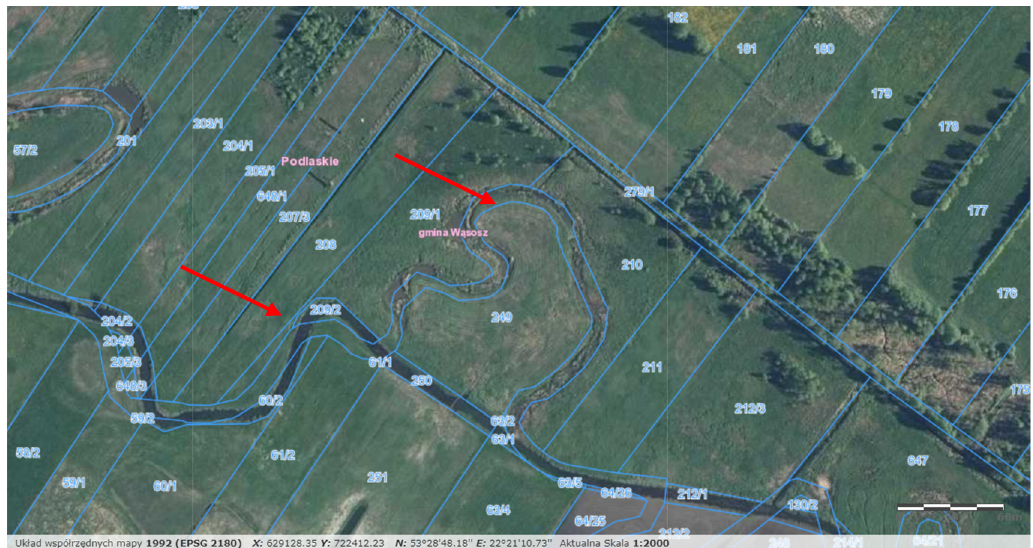
Figure 5. An example of an object with an easily modified border: the Wissa River. Source: own study on [52].